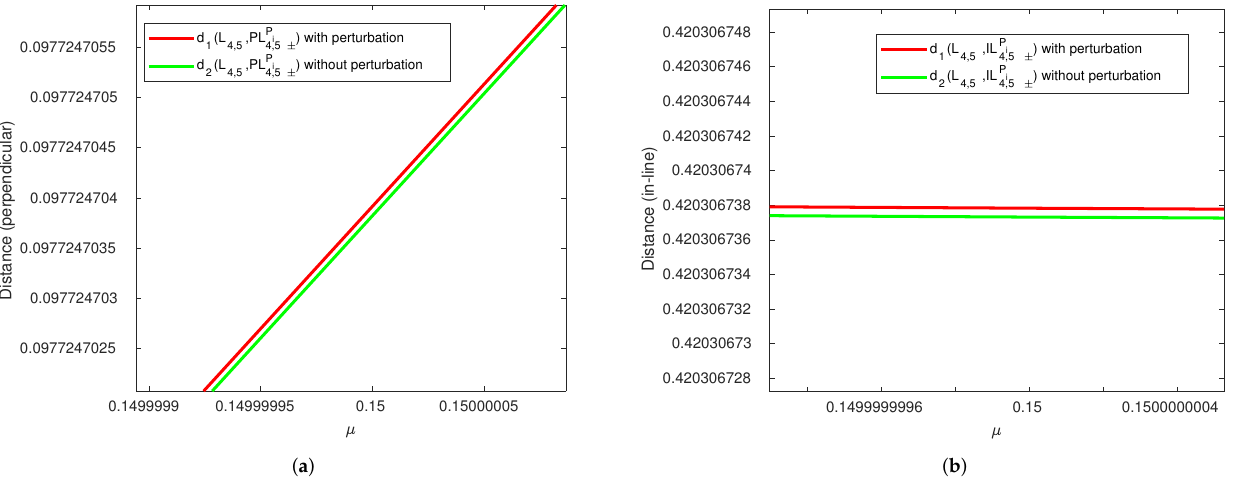
Figure 6. Comparison of distance versus µ between perturbed (red line) and unperturbed (green line) noncollinear equilibrium points in R2+2BP. ( a ) Perpendicular equilibrium points. ( b ) Inline equilibrium